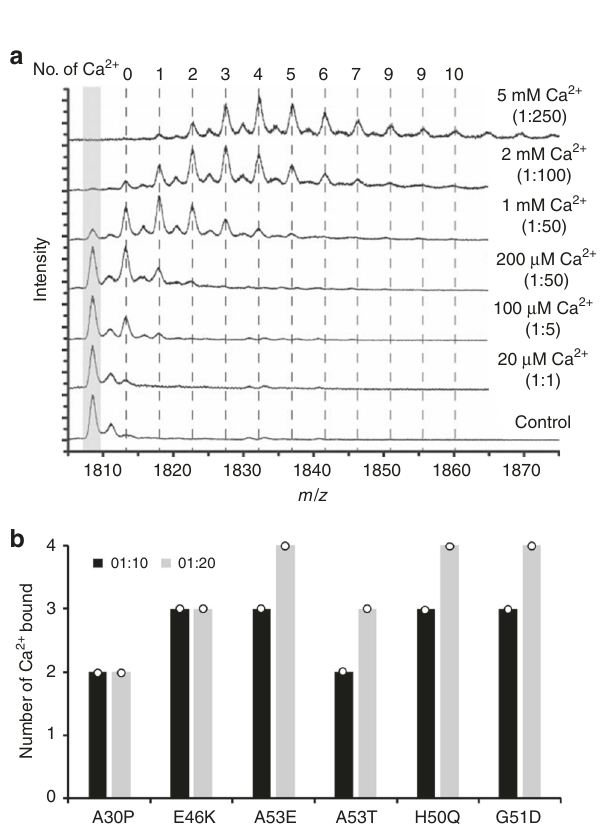
Fig. 5 Native nano ESI-MS shows no signi fi cant difference in number of calcium ions bound. a A calcium titration from 20 μ M to 5 mM shows increasing numbers of calcium ions bound to WT aSyn in the + 8 charge state (20 μ M in 20 mM ammonium acetate) with a maximum of 10 calcium ions bound at a 1:250 ratio (the full spectrum is displayed in Supplementary Fig. 13). b At ratios of 1:10 (black) and 1:20 (grey) aSyn to calcium a maximum of two to four calcium ions are bound to aSyn mutants (mass spectra are displayed in Supplementary Fig. 14). The number of calcium ions bound in three replicates was the same for all aSyn mutants, as displayed by the circle, therefore, no error is electrostatic repulsion is reduced, leading to altered long-range electrostatic interactions and enhanced hydrophobic interaction between the C-terminus and the NAC region which drives aggregation 22,49 – 52 . We observed mutant speci fi c differences in long-range interactions, compaction and solvent exposure com- pared to WT aSyn which correlate to aggregation propensity and will be discussed individually.